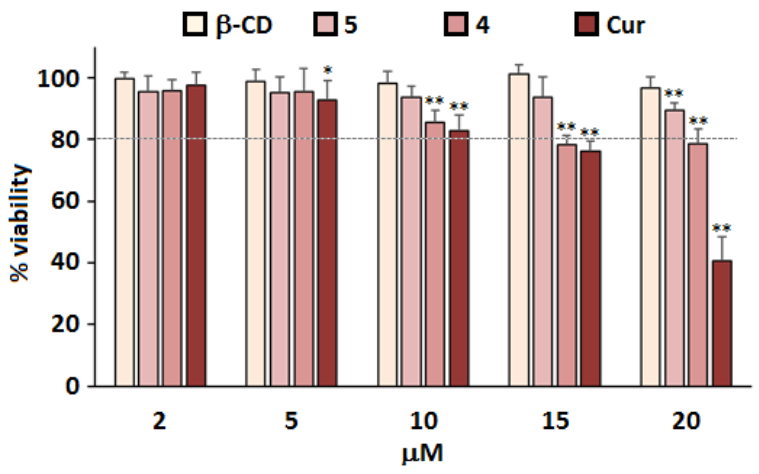
Figure 5. Cytotoxicity of β-CD@Cur 4 and (β-CD) 2 @Cur 5 nanoconjugates. Primary cultures of rat embryo cortical neurons were isolated and prepared on Day 0 (D0) in vitro, followed by treatment on D3 with the indicated concentrations of Cur. MTT assay was performed after 24 h to assess cell viability. Results are shown as % of viability of control cells treated with the same volume of DMSO alone; means and SD are shown for two separate cultures each with quadruplicate determinations. Statistical significance is shown as compared to values obtained from control cells (* p < 0.05, ** p < 0.01).